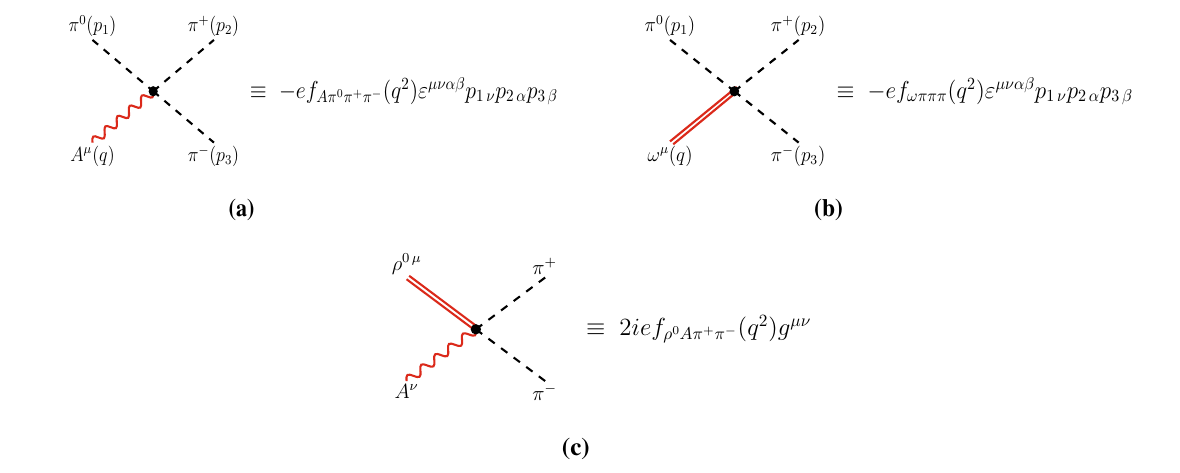
Fig. 9 Quartic vertices of the HLS model taken into account in the present work √ Table 1 The cross sections in pb at s = 1 GeV and the corresponding U ( 1 ) gauge invariance tests. The numbers in parentheses show the MC uncertainty of the last decimals Process ISR Full